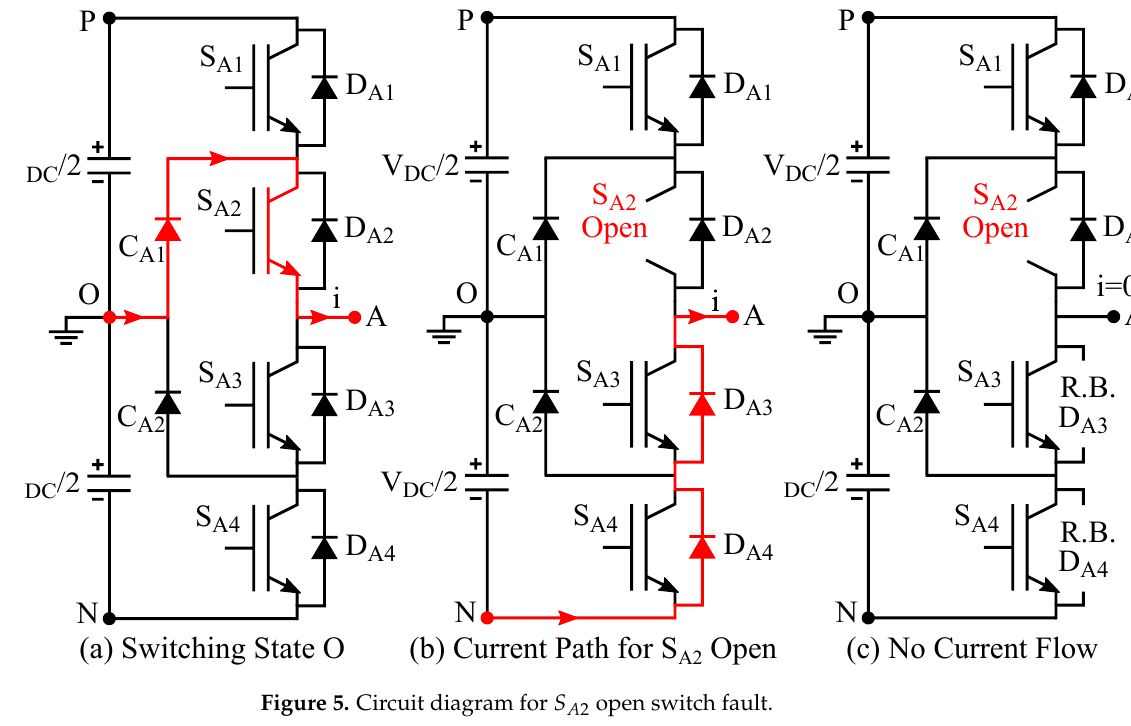
Figure 5. Circuit diagram for S A 2 open switch fault.